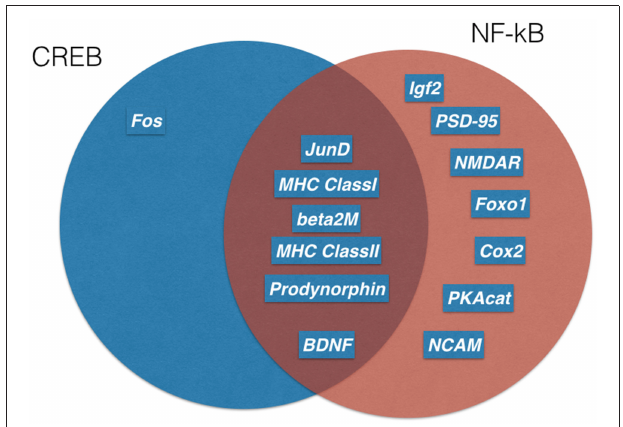
FIGURE 4 | Scheme of a post-synapse. Some NF- κ B target genes as AMPAR, Igf2, and PSD95 are crucial components of the post-synaptic compartment and involved in signal transmission. Association of NF- κ B with the scaffold is suggested by biochemical fractionation but was not directly